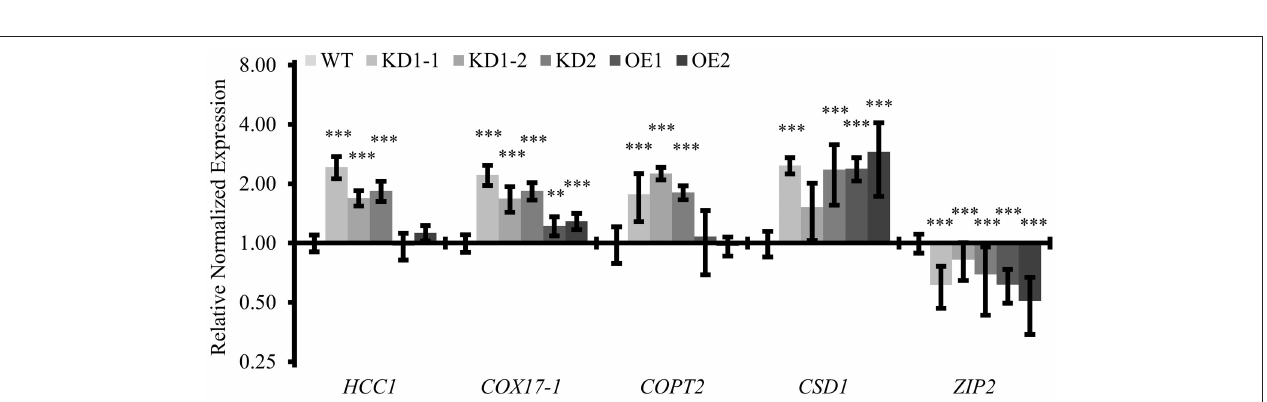
FIGURE 8 | Influence of Cu treatment on root growth of COX11 mutants. Relative root growth of 12-day-old WT and KD (A) as well as WT and OE (B) seedlings cultured on plates with copper excess or deficiency (BCS). Root length is expressed relative to WT or mutant seedlings on control plates. Roots were measured in three independent experiments. Error bars represent ± SD for n = ∼ 40 (WT), ∼ 30 (KD1-1, KD1-2), and ∼ 35 (OE1, OE2). Asterisks indicate statistical significance calculated with the Student’s t -test (mutant line compared with WT, * P < 0.05 ; ** P < 0.01 ). Individual values are listed in the Supplementary Table 5. BCS, bathocuproinedisulfonic acid.